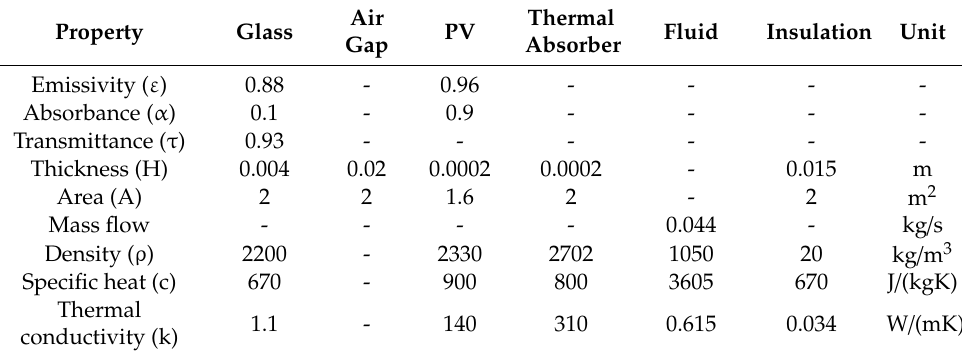
Figure 1. The PVT collector: ( a ) direct flow collector geometry; ( b ) cross section of the PVT collector [16]. Table 1. The geometrical, thermo-physical and optical properties of the photovoltaic-thermal (PVT)